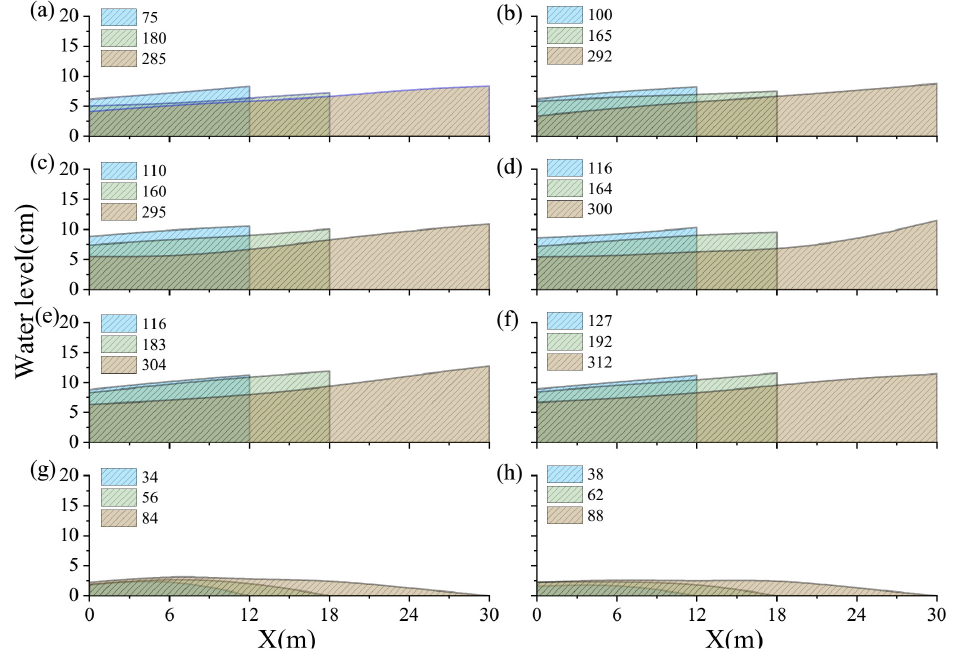
Figure 6. Water level for initial irrigation water positions of 6 m, 18 m, and 30 m in the furrow of different treatments. ( a ) B1; ( b ) A1; ( c ) B2; ( d ) A2; ( e ) B3; ( f ) A3; ( g ) B4; ( h ) A4.